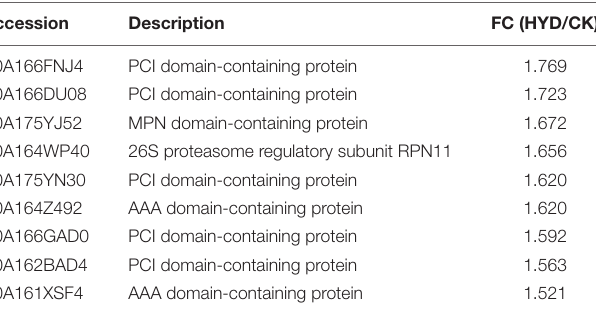
TABLE 2 | Upregulated DAPs involved in proteasomes (pathway ID: map03050) in HYD vs. CK.